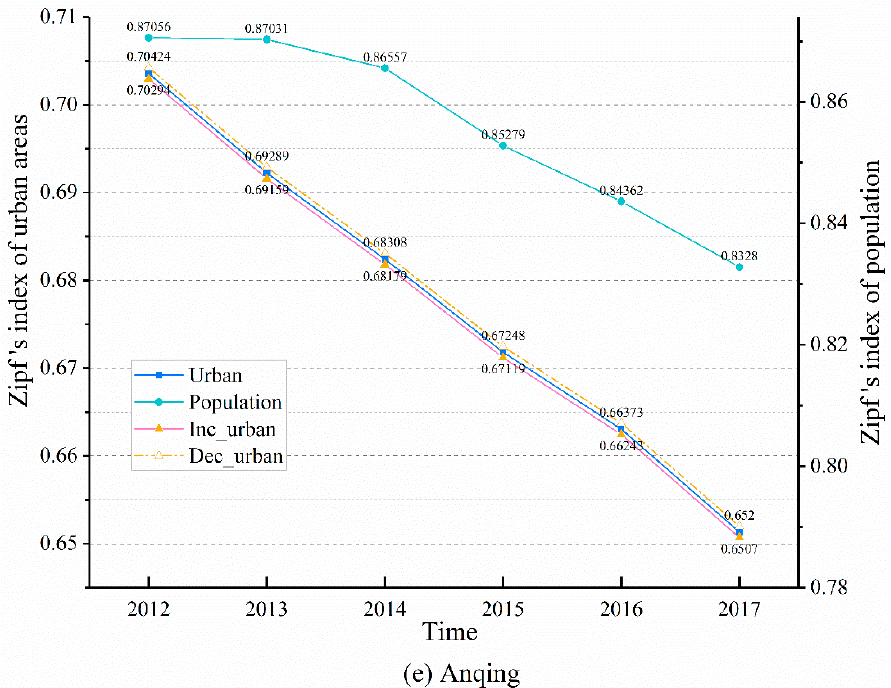
Figure 9. Variations in the Zipf’s index of the YRD from 2012 to 2017; the “Inc_urban” and “Dec_urban” represent the results calculated from urban areas of five cities that increased by 5% and decreased by 5%, respectively.